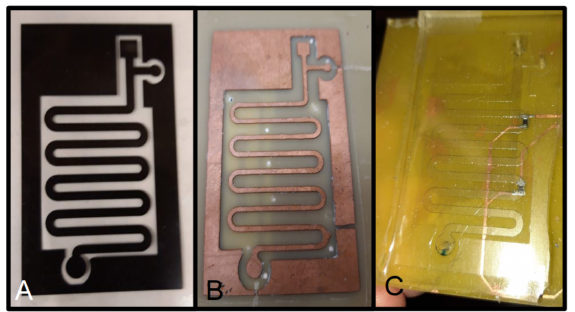
Figure 19. ( A ) Photolitographic mask for fabricating the PCB-based mold. ( B ) Mold for a serpentine microchannel. ( C ) PDMS fabricated device using the mold.